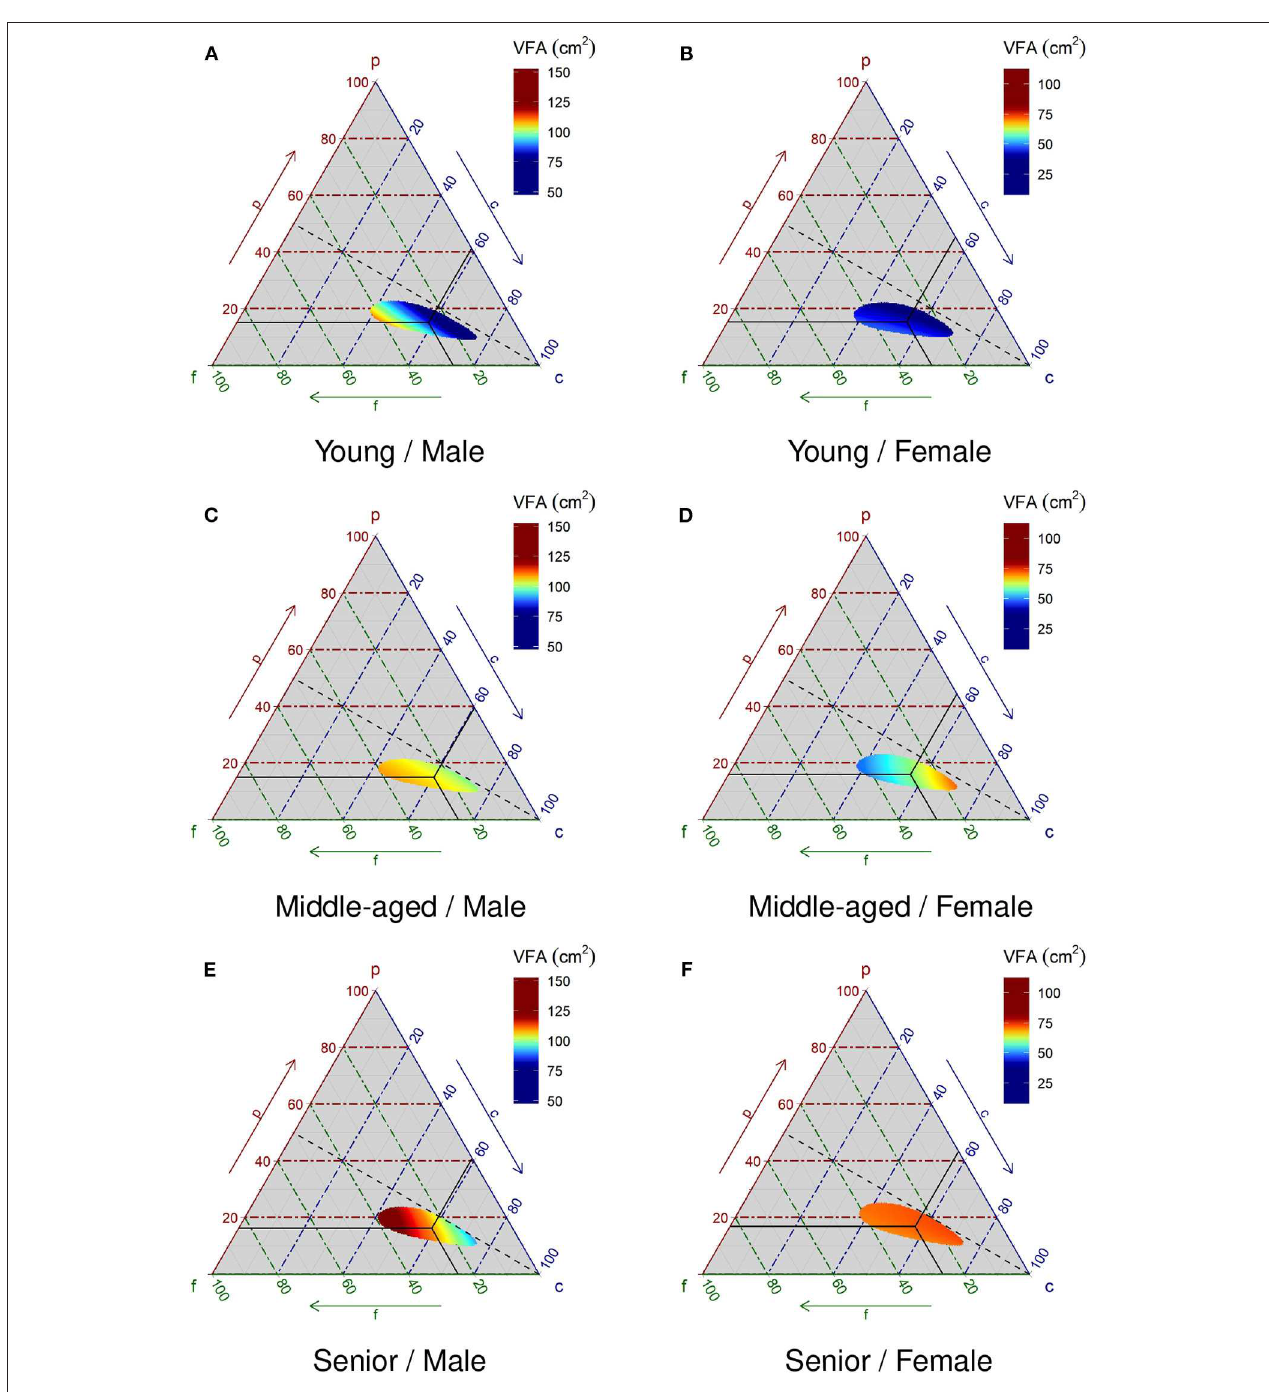
FIGURE 5 | Relationship between macronutrient composition and visceral fat area. The visceral fat area in color is predicted by the statistical model in Equation (4). The statistical model is a multiple regression model with the square root converted visceral fat area as the objective variable and the isometric log-ratio converted macronutrient energy ratio and its squared term, gender, age group, and those interaction terms as explanatory variables. The cross-hair indicates the center of the compositional data in each stratum. The dotted line indicates equal ratio of protein and fat. (A) , (C) , and (E) are male groups of Young, Middle-aged, and Senior, respectively. (B) , (D) , and (F) are female groups of Young, Middle-aged, and Senior, respectively. Young, Middle-aged, and Senior are defined as 20 to 34 years old, 35 to 59 years old, and 60 and older, respectively. Scales for males and females are different.